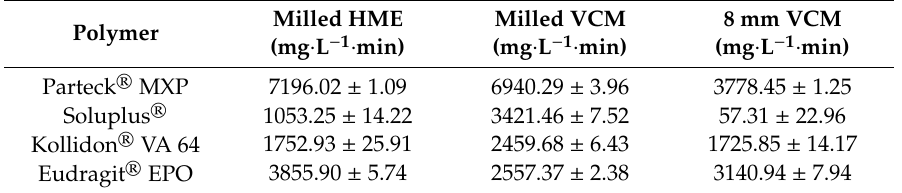
Table 7. Area under the curve (AUC) ± RSD for release profiles of HME and VCM samples ( n = 3).